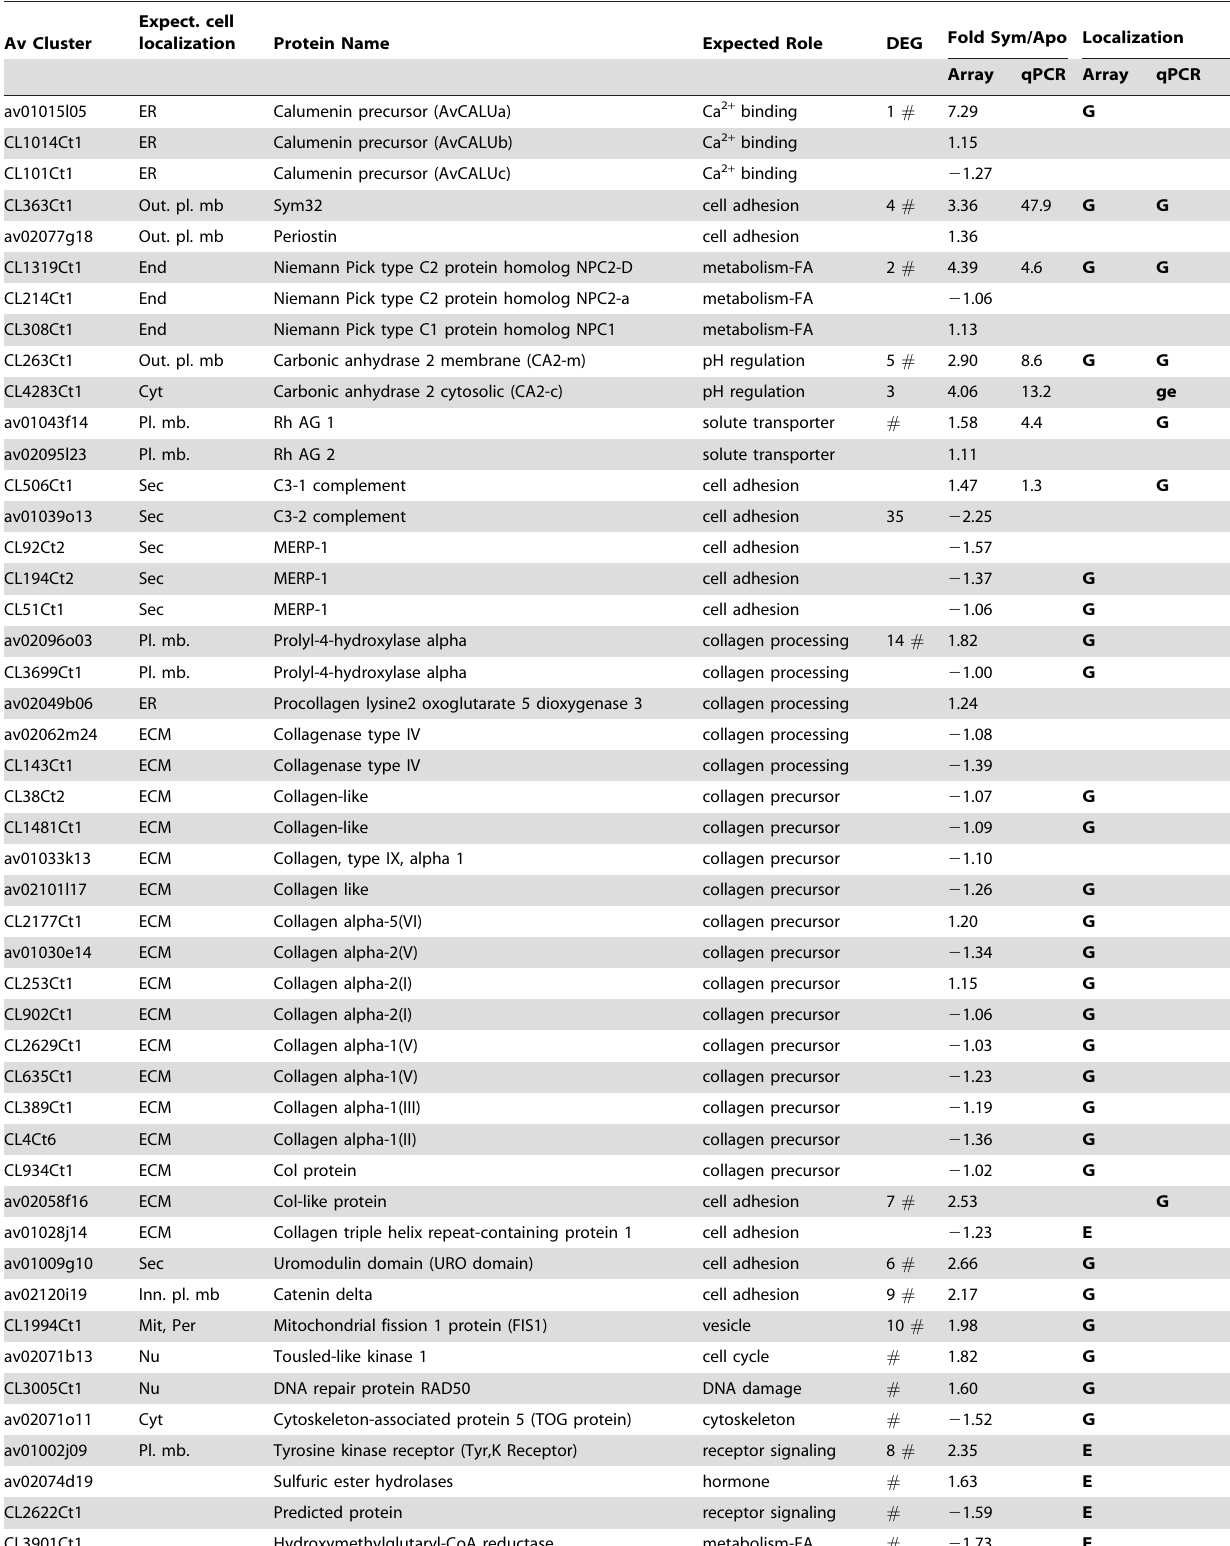
Table 2. Examples of A. viridis genes up-regulated in the epidermis (E) or gastroderm (G).